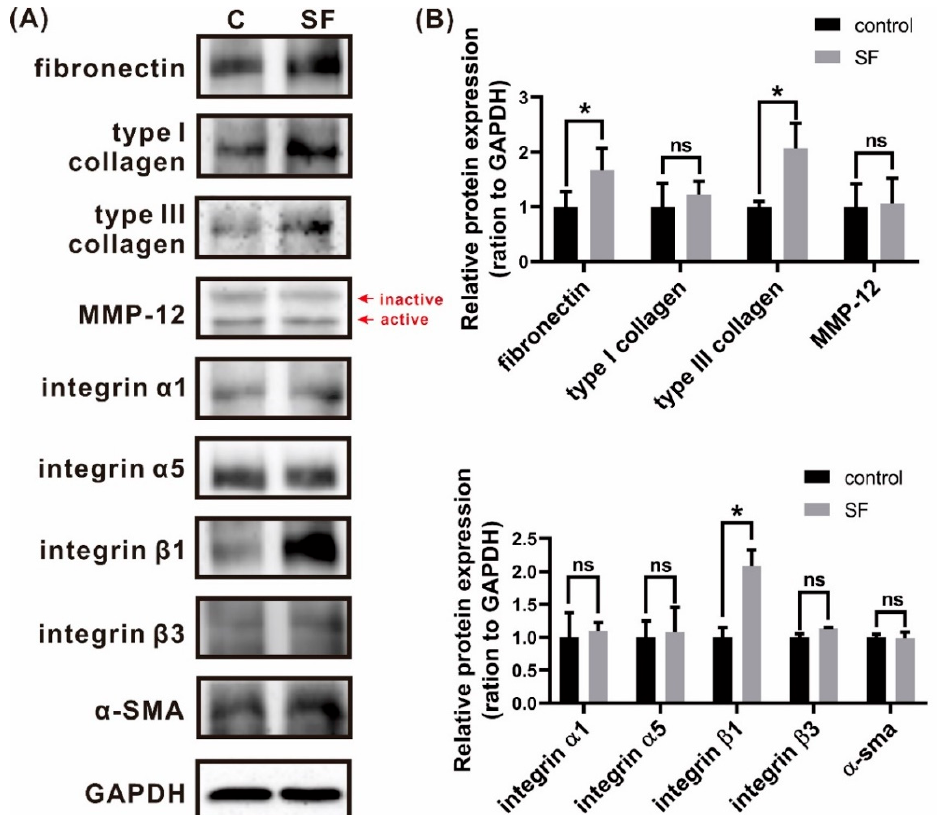
Figure 9. The protein expression in control and SF (silk fibroin) groups at 168 h were detected using Western blot analysis. ( A ) Fibronectin, type I collagen, type III collagen, MMP-12, integrin α 1, α 2, β 1, β 3, and α -SMA. ( B ) Quantitative representations showed the relative expression in the control and SF groups. Data are presented as the mean ± standard error. * p < 0.05, ns: not significant). α -SMA, alpha-smooth muscle actin; GAPDH, glyceraldehyde 3-phosphate dehydrogenase; MMP-12, matrix metalloproteinase-12.